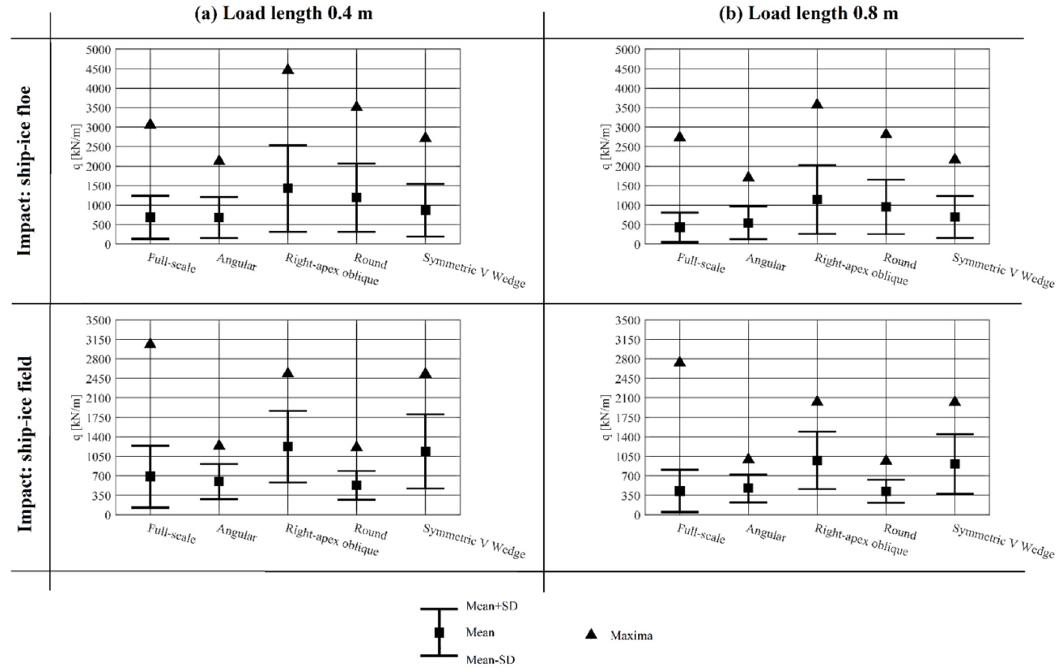
Figure 8. Comparison of measured line loads with estimated by Popov Method for data set B.